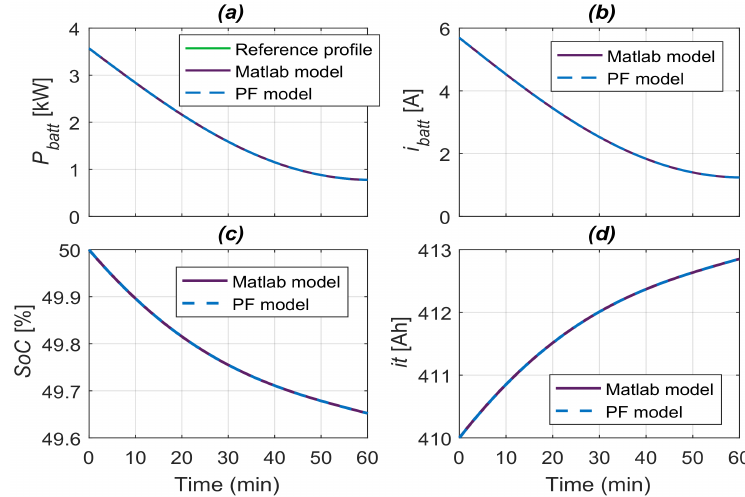
Figure 12. Battery Energy Storage System (BESS) model validation: ( a ) power reference profile and active power obtained, ( b ) battery current, ( c ) SoC , ( d ) it .